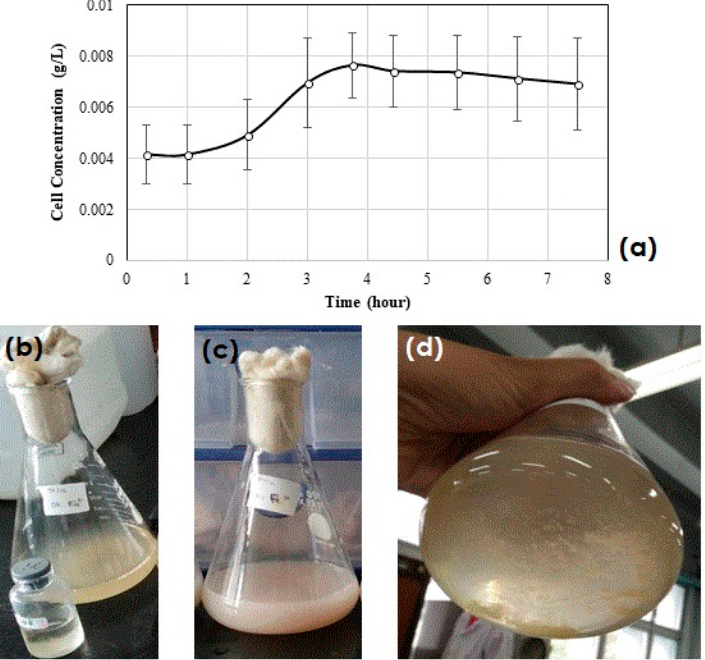
Figure 1. Experimental results of the sulfur recovery: ( a ) Thiobacillus growth curve, ( b ) initial condition, ( c ) cell formation peak of fermentation (4–6 h), ( d ) solid sulfur precipitation at the end of fermentation (>20 h).